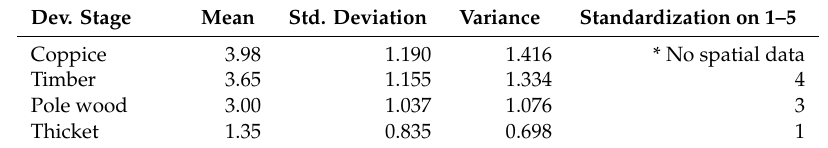
Table 3. Teachers’ forest development stage preferences when visiting a forest with kindergarten groups. Dev.